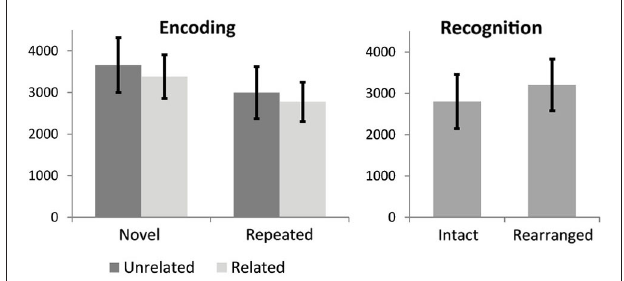
FIGURE 2 | Reaction time results for encoding conditions . Error bars show standard